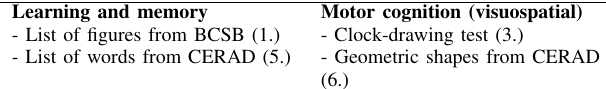
N EUROPSYCHOLOGICAL INSTRUMENTS SEPARATED BY NEUROCOGNITIVE